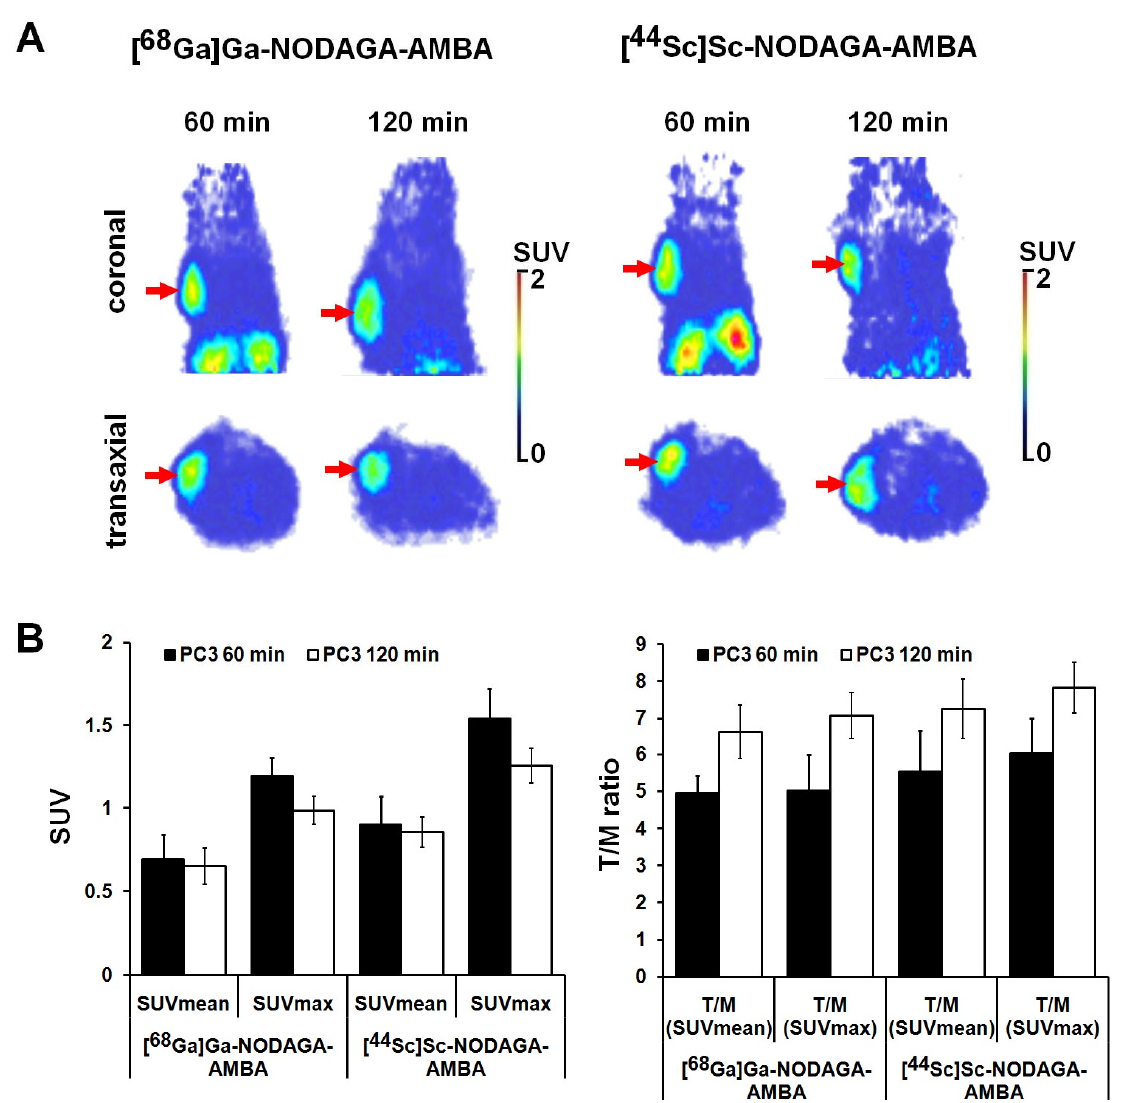
Figure 4. In ‐ vivo assessment of tumor ‐ targeting properties of [ 68 Ga]Ga ‐ NODAGA ‐ AMBA and [ 44 Sc]Sc ‐ NODAGA ‐ AMBA radiotracers. ( A ) positron emission tomography (PET) imaging and quantitative image analysis of PC ‐ 3 tumors [ 68 Ga]Ga ‐ NODAGA ‐ AMBA and [ 44 Sc]Sc ‐ NODAGA ‐ AMBA radiotracers. ( A ) Representative coronal ( upper row ) and transaxial ( lower row ) decay ‐ corrected PET images of GRPR ‐ positive PC ‐ 3 tumor ‐ bearing mice 60 and 120 min post ‐ injection, and 14 ± 1 days after tumor cell inoculation. ( B ) quantitative standardized uptake value (SUV) analysis of [ 68 Ga]Ga ‐ NODAGA ‐ AMBA and [ 44 Sc]Sc ‐ NODAGA ‐ AMBA accumulation in experimental PC3 tumors (n = 5 animals/radiotracer/time point). Red arrows: PC3 tumors; T/M: tumor ‐ to ‐ muscle ratio. SUV values are presented as mean ± SD.